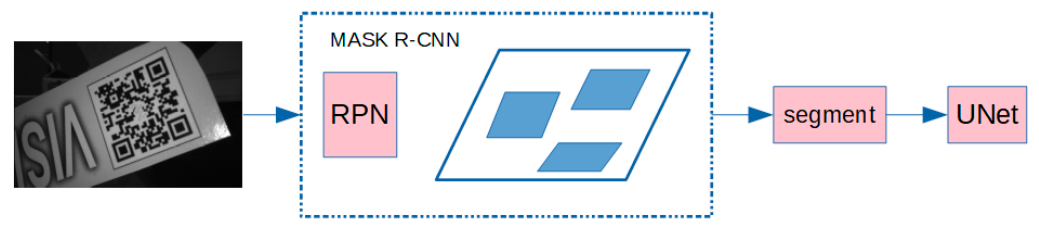
Figure 9. Prediction process using trained MU R-CNN model.